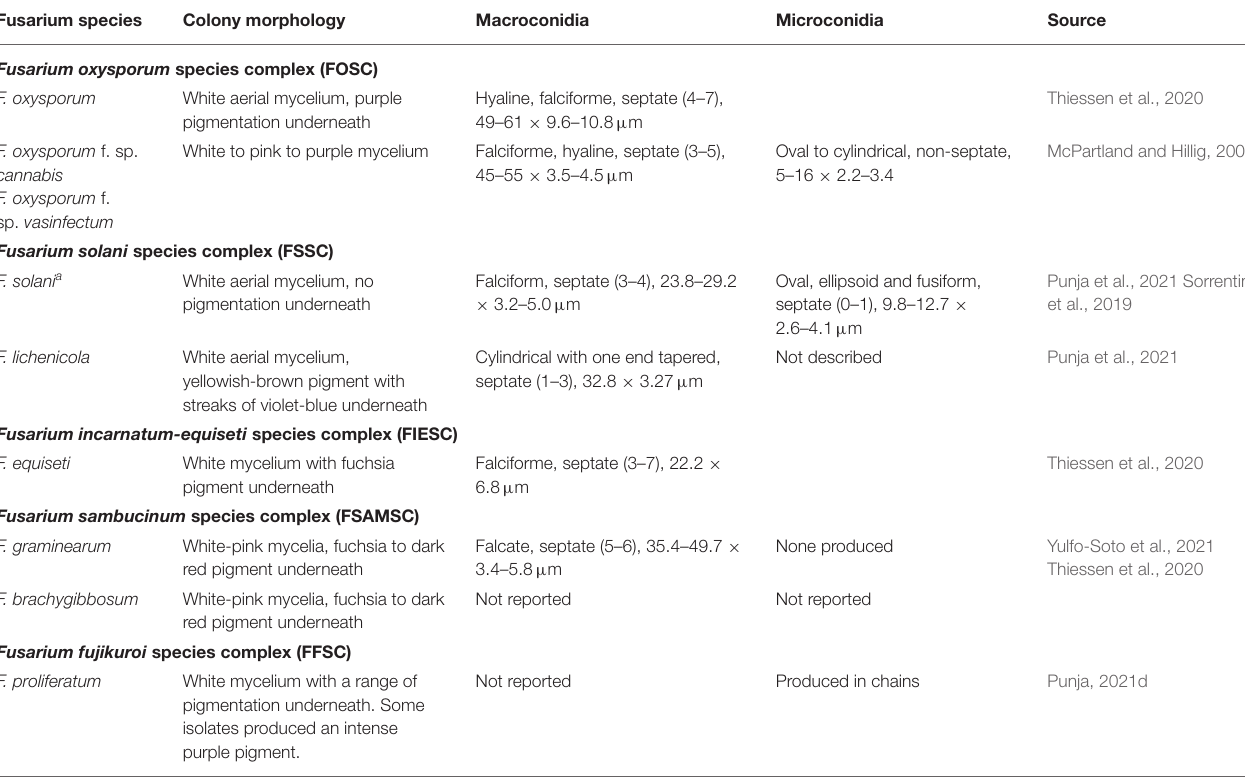
TABLE 2 | Descriptions of macro- and micro-morphological characters of Fusarium spp. isolated from Cannabis